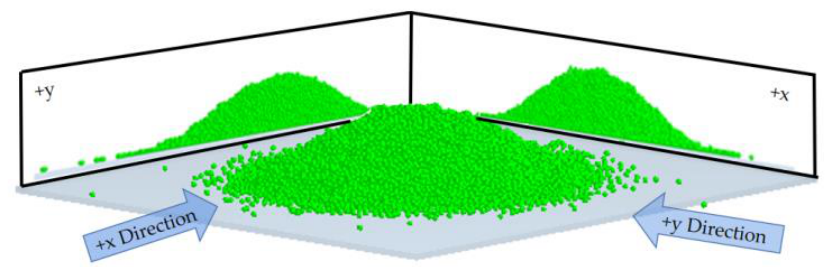
Figure 3. Simulation model of the soil stacking angle.